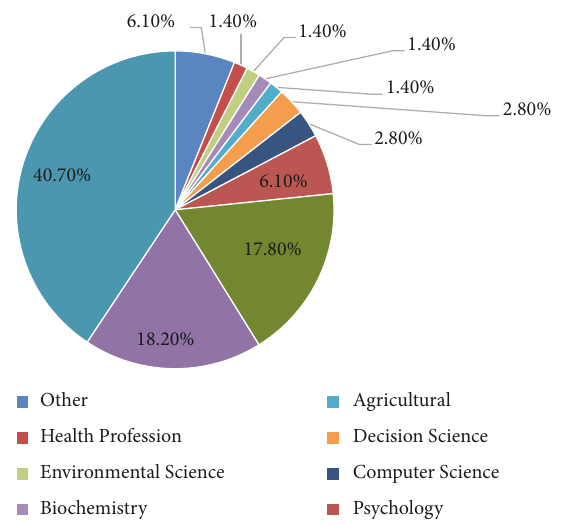
Figure 27: Pie chart depicting article distribution by disciplines for mixed studies review articles.